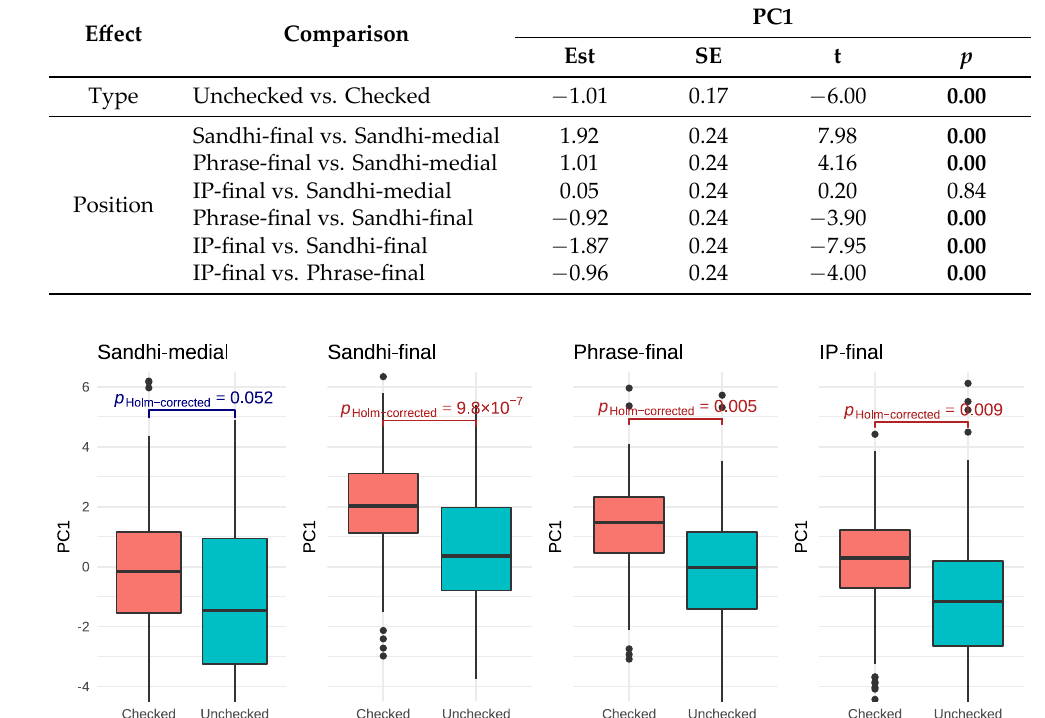
Table 2. Outputs of linear mixed‑effect regression for PC1 without interaction effects. Significant p ‑values are marked in bold.